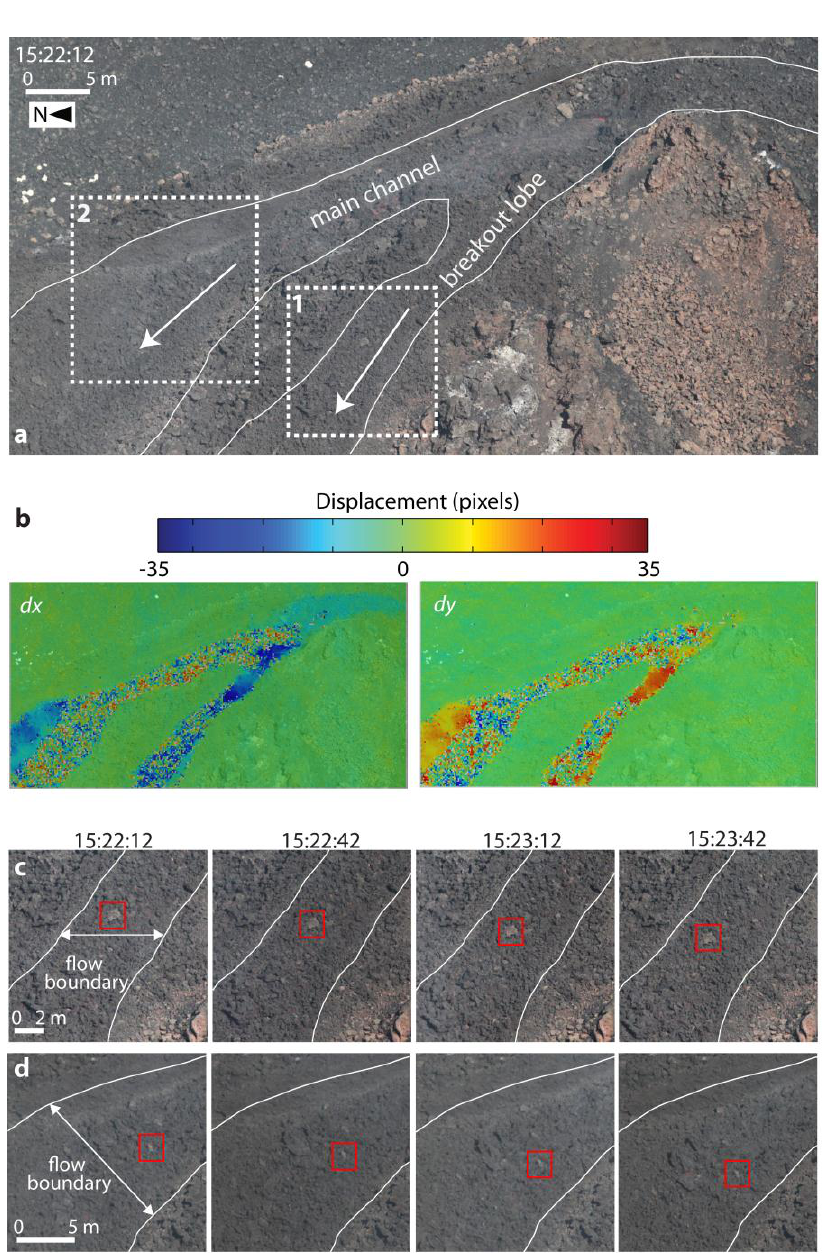
Figure 5. Time-lapse images of the active flow. ( a ) A near-full image showing the areas used to determine flow velocity for the breakout flow (Box 1) and main channel (Box 2). ( b ) The results of automated pixel displacement analysis using a particle image velocimetry (PIV) approach (covering the area shown in (a) for the 15:22:12–15:22:42 image pair, analysed using PIVlab v1.4 [57,58]), split into x - and y -displacement components. Regions of smooth colour represent successful image matching; speckled areas indicate regions of noise where the matching has failed to track the flow surface movement. Extracts from the image sequence are shown for ( c ) the Region 1 and ( d ) the Region 2 areas displayed in (a), with the red boxes highlighting typical surface features that can be tracked with interactive techniques. Approximate scales are given for